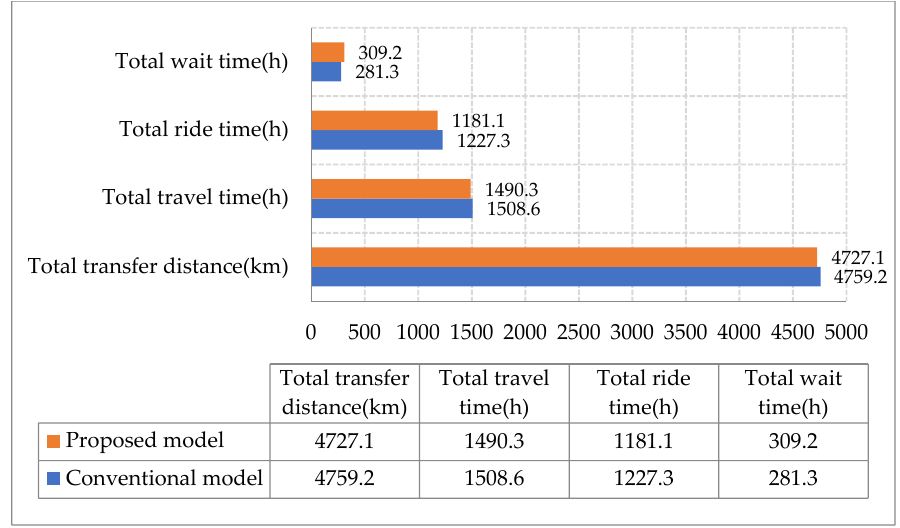
Figure 8. Comparison of the results obtained via the proposed and conventional models. Compared with the conventional model, the total transfer distance of the proposed model was reduced by 32.1 km. In this research, the total ride time decreased while the total waiting time increased. The objective value in this research was smaller than that of the conventional model, as the increase in the former was less than the decrease in the latter. This was because the study took the route design and departure frequency into account to seek global optimization, preventing the local optimum of the conventional approach, in which the route design was decided first, and then the departure frequency was computed. 6.3. Comparative and Sensitivity Analyses Sensitivity analyses were reformed to examine the effects of the number of routes, station capacity, and load factor on the model performance. Table 6 summarizes the effect of the number of routes. Table 6. Effect of the number of routes on the proposed model performance. Scenario Total Travel Time (h) Total Riding Time (h)